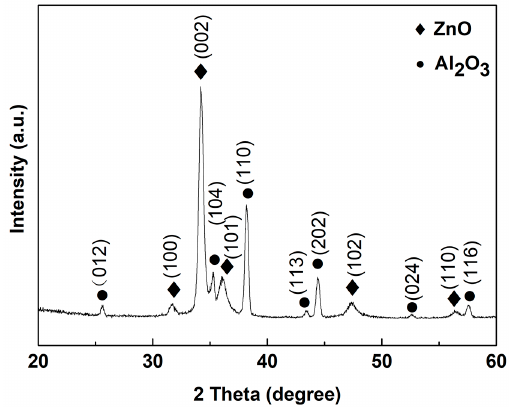
Figure 2. XRD pattern of the synthesized ZnO film deposited by RF magnetron sputtering.